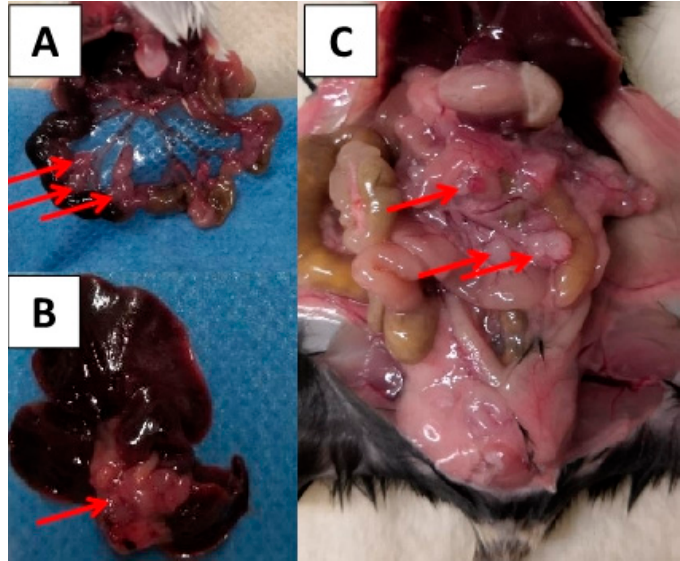
Figure 4. Lymph node metastasis ( A ), liver metastasis ( B ), and peritoneal carcinosis ( C ) detected during gross examination. The metastases are indicated by red arrows.